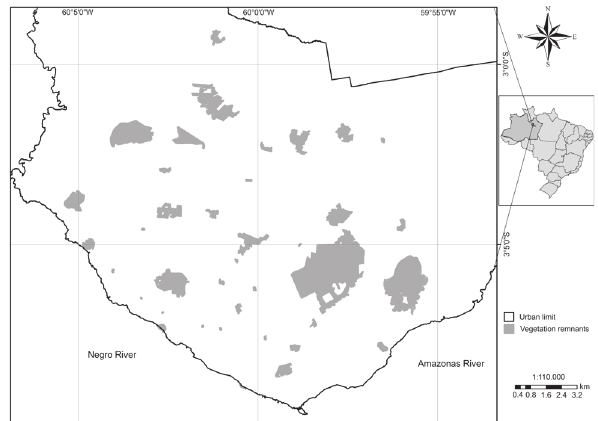
Figure 1. Spatial distribution map of the 40 vegetation remnants investigated for occupancy by communal roost of Black Vultures ( Coragyps atratus ) in the urban area of Manaus, Amazonas,